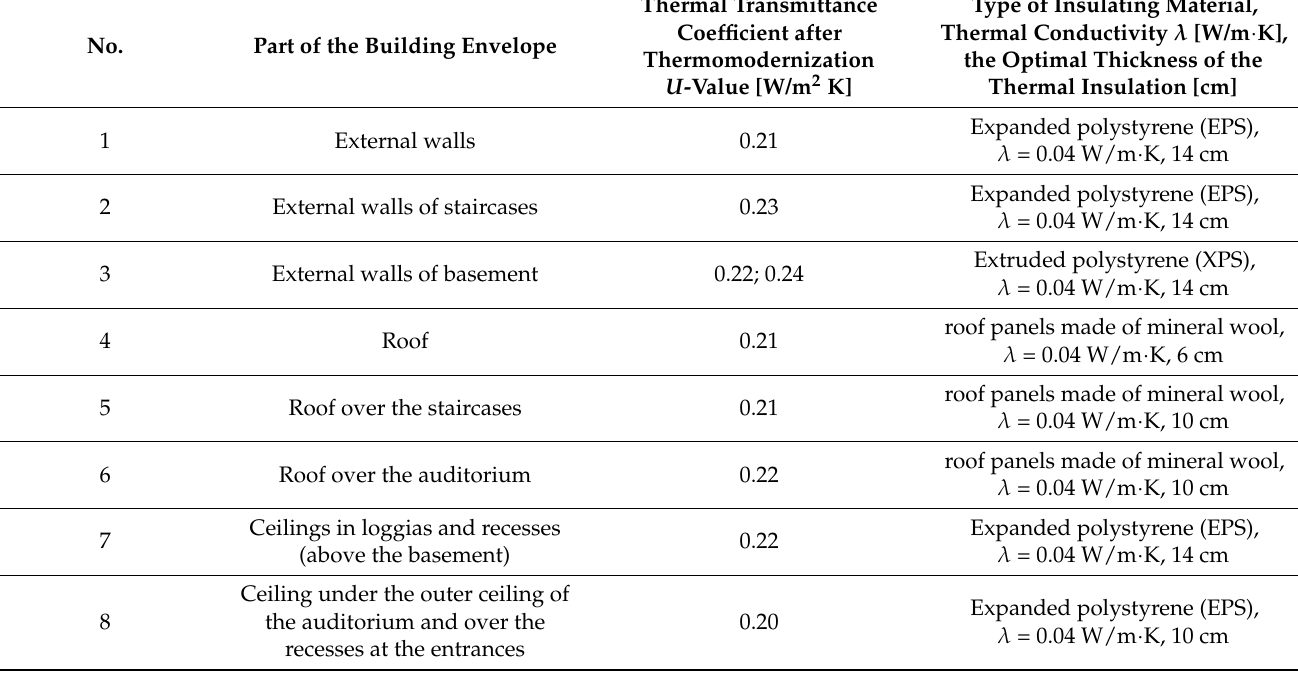
Table 6. List of the calculated values of thermal transmittance coefficients of building partitions after thermomodernization, along with the type of insulation material and the adopted optimal thickness